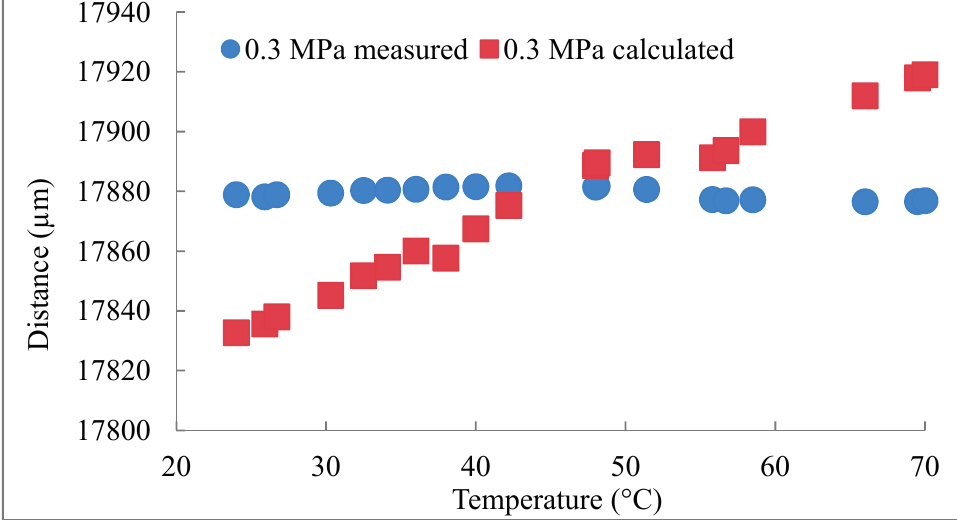
Figure 3. Experiment in 0.3 MPa pressure. σ